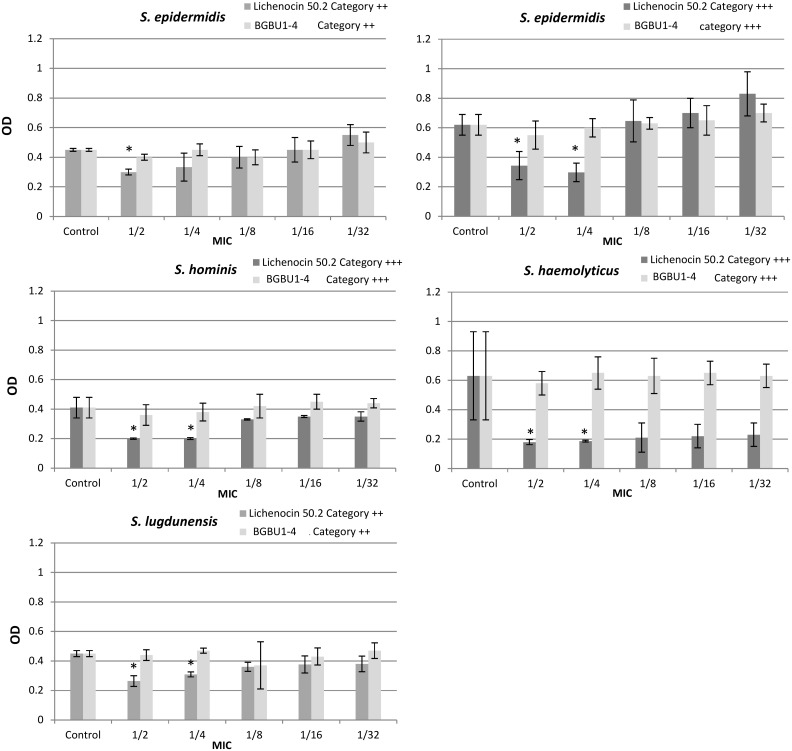
The effect of lichenocin 50.2 and BGBU1-4 crude extract on biofilm formation of coagulase negative staphylococci.The effect of subinhibitory concentrations (1/2–1/32 X MIC) of lichenocin 50.2 and BGBU1-4 crude extract on biofilm formation of S. epidermidis, S. hominis, S. haemolyticus and S. lugdunensis. Results are presented as mean OD ± standard deviation; Category ++, moderate biofilm producer; Category +++, strong biofilm producer; * p<0.05. Control–biofilm density of bacteria cultivated in medium without presence of bacteriocins.